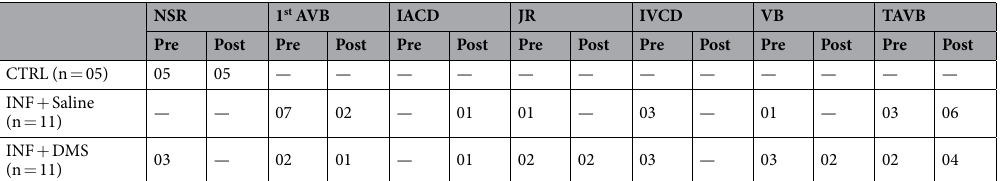
INF + Saline (n = 11) — — 07 Table 1. Number of animals per arrhythmias before treatment (Pre) and at the end of treatment (Post) in naive (CTRL), chronic infected and vehicle-treated (INF + Saline) and chronic infected, DMS-treated (INF + DMS) groups. In infected groups, some animals developed more than one type of arrhythmias. NSR = Normal sinus rhythm, 1 st AVB = 1 st degree atrio-ventricular block, IACD = Intra-atrial conduction disturbance, JR = Junctional rhythm, IVCD = Intra-ventricular conduction disturbance, VB = Ventricular bigeminism, TAVB = Total atrio-ventricular dissociation.